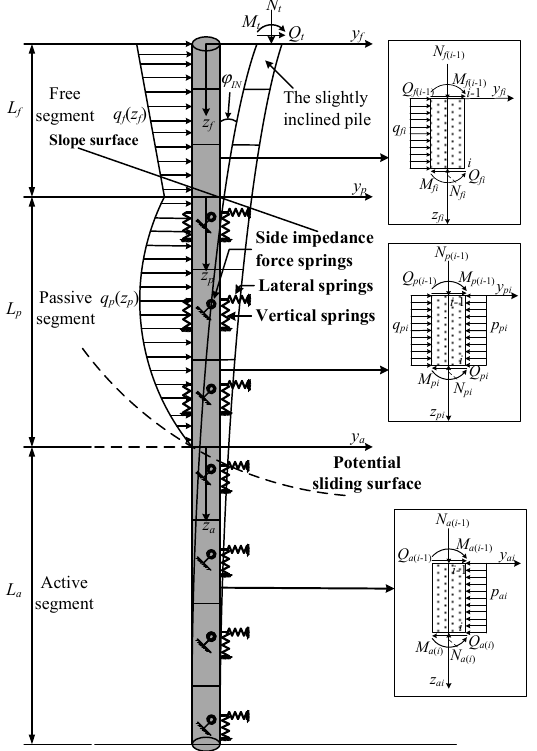
Figure 1. Simplified model for the slightly inclined pile in sloping ground.